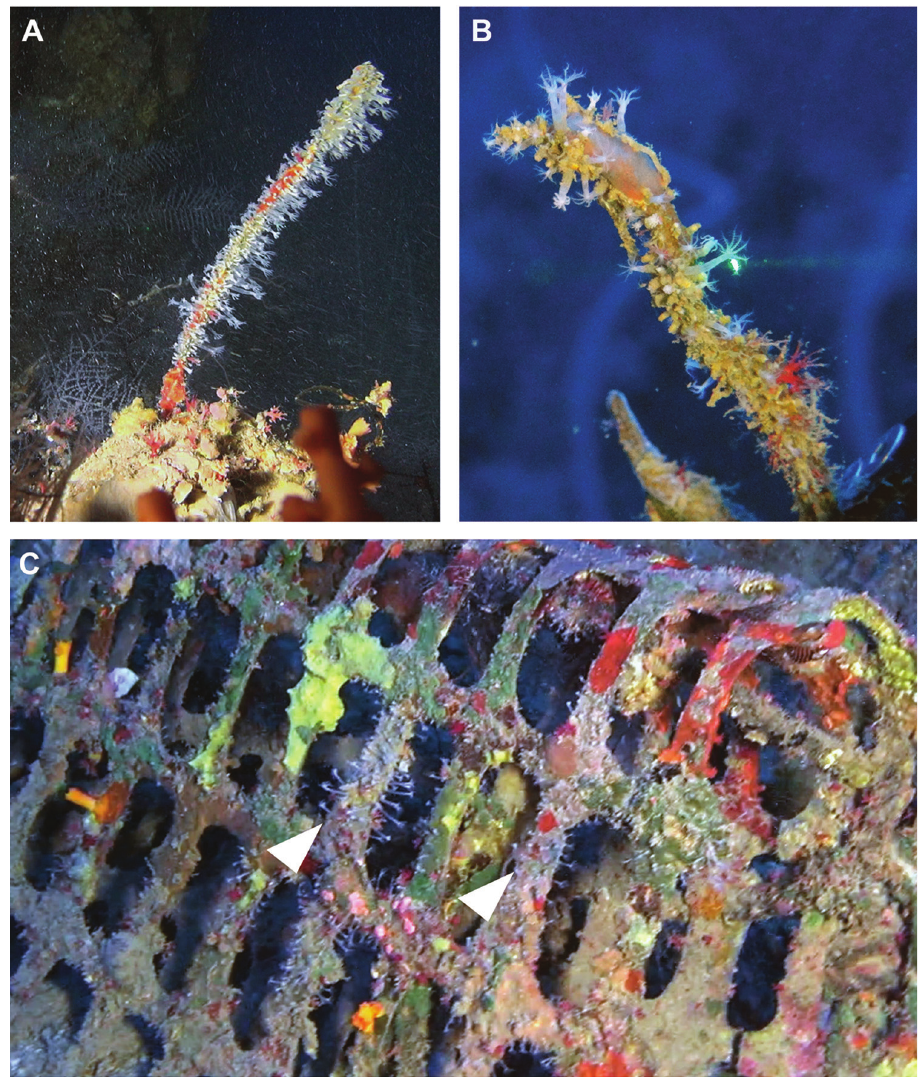
Figure 3. Altumia delicata gen. n. sp. n. live colonies. A, B colonies growing over branch of black coral with expanded polyps C colonies growing on PVC net (arrow